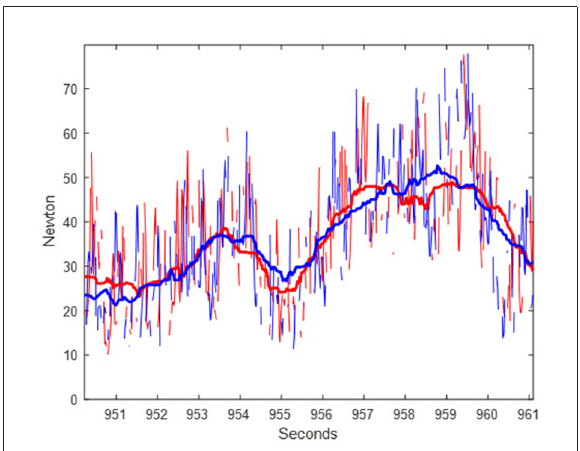
FIGURE1 Example of raw and filtered rein tension data from a segment of racing (fast) trot for one horse during 10s. Traces represent raw and filtered data for the left (red) and right (blue) rein.